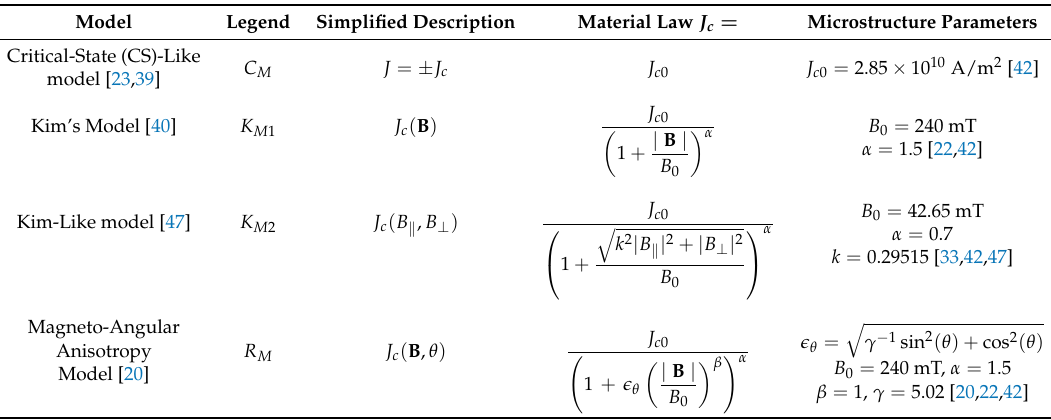
Table 1. Material law models and related variables considered within the E-J power law formulation for the rare-earth barium-copper oxide (REBCO) material in Equation (1). Model Legend Simplified